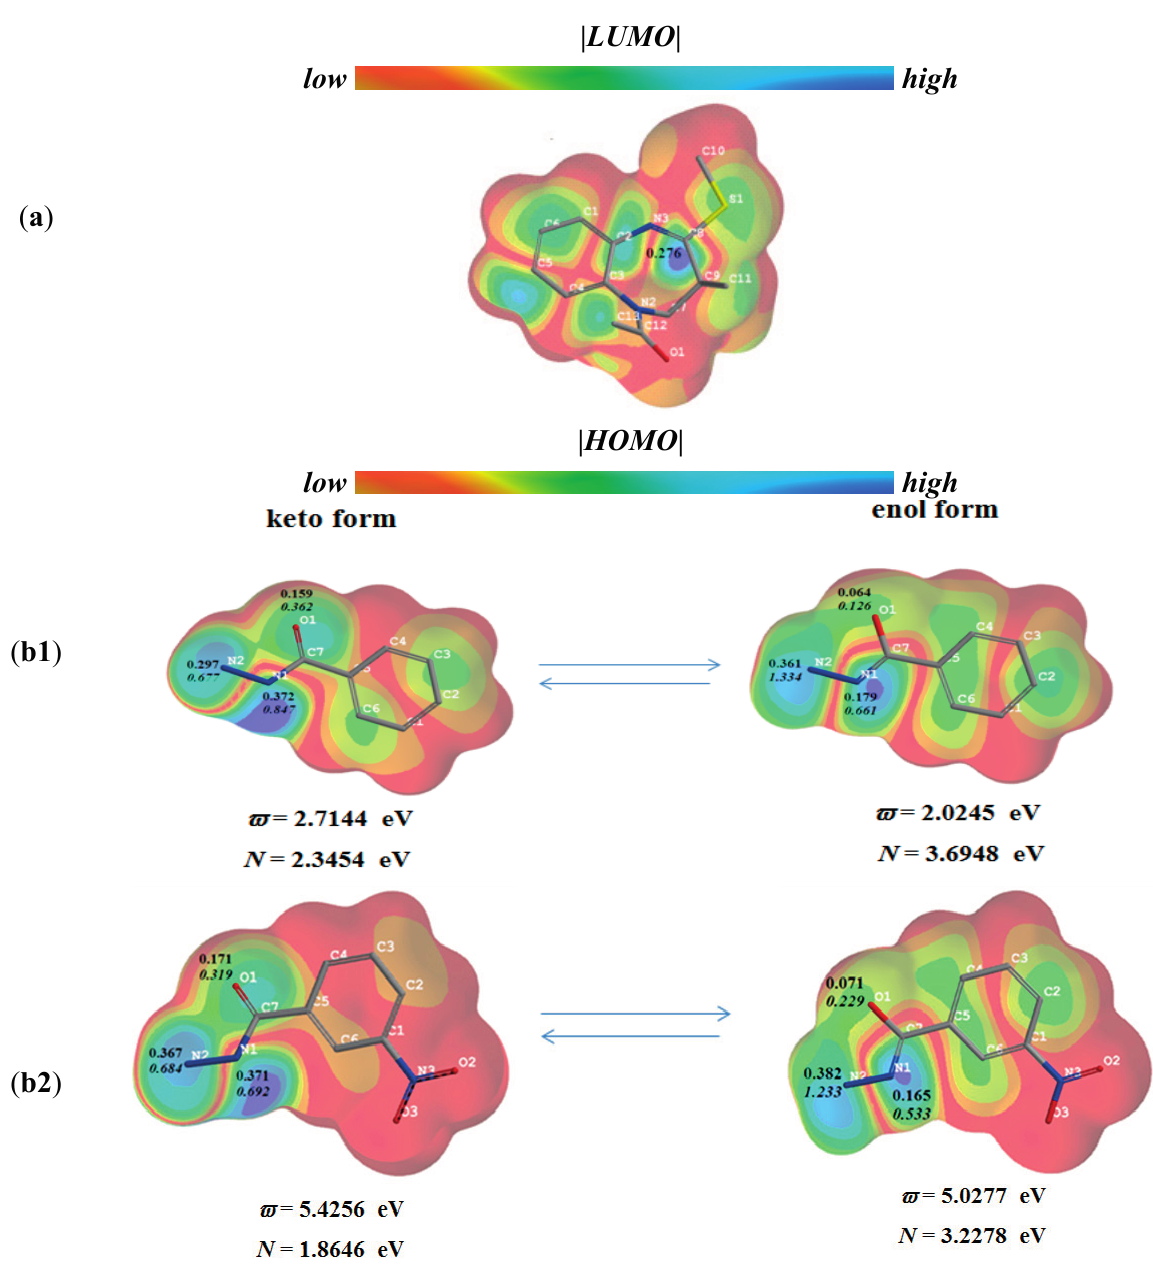
Figure 1. ( a ) | LUMO | map and electrophilic Fukui function ( F + k ) value of thioether compound 2d ; ( b1 ) | HOMO | map and nucleophilic Fukui index ( F − k ) values of keto- and enol- form of benzohydrazide; ( b2 ) | HOMO | map and F − k values of keto- and enol-form of 3-nitro-benzohydrazide. The global reactivity indices of the compounds: electrophilicity index ( ϖ ) and nucleophilicity index (N). | LUMO | and | HOMO | izo-values =